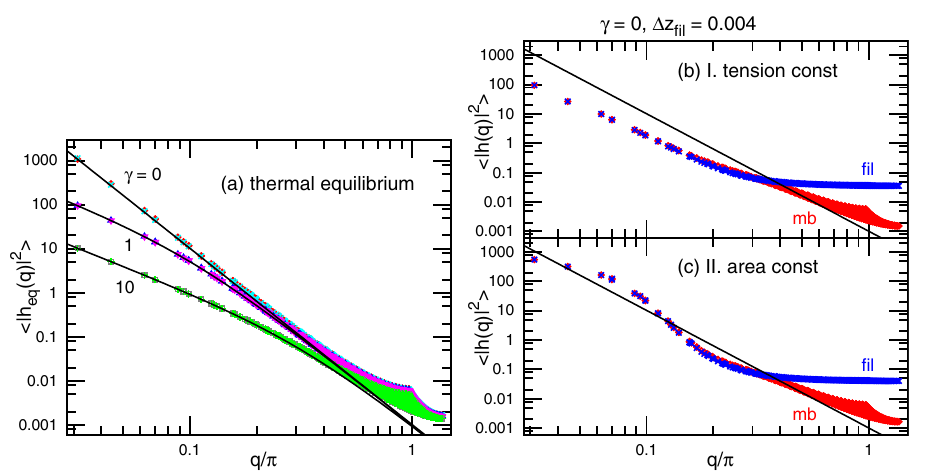
2 h ( q ) Figure 2. Spectra of undulation modes . ( a ) Membrane under thermal equilibrium at γ �| | � 10. The symbols ( , ▽ , and ) and ( , , and (cid:31) ) represent the spectra in cases I (tension constraint) and II × △ + ⋄ γ q 2 ) with κ 10 . ( b , c ) The undulation spectra (area constraint), respectively. Solid lines show 1 /(κ q 4 = + of the membrane (red diamonds) and filament tips (blue cross marks) of tensionless membranes ( γ (cid:31) z fil 0.004 for ( b ) case I and ( c ) case II. The error bars are smaller than the symbol =